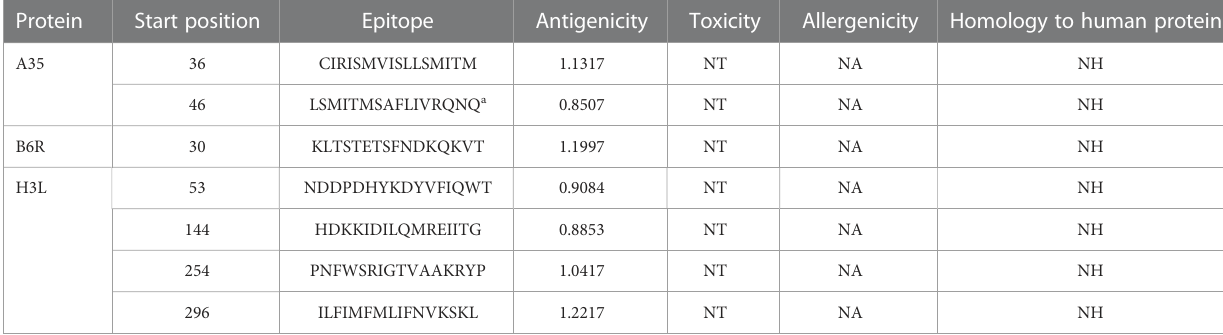
TABLE 3 List of the B-cell epitopes selected for vaccine construction. Protein